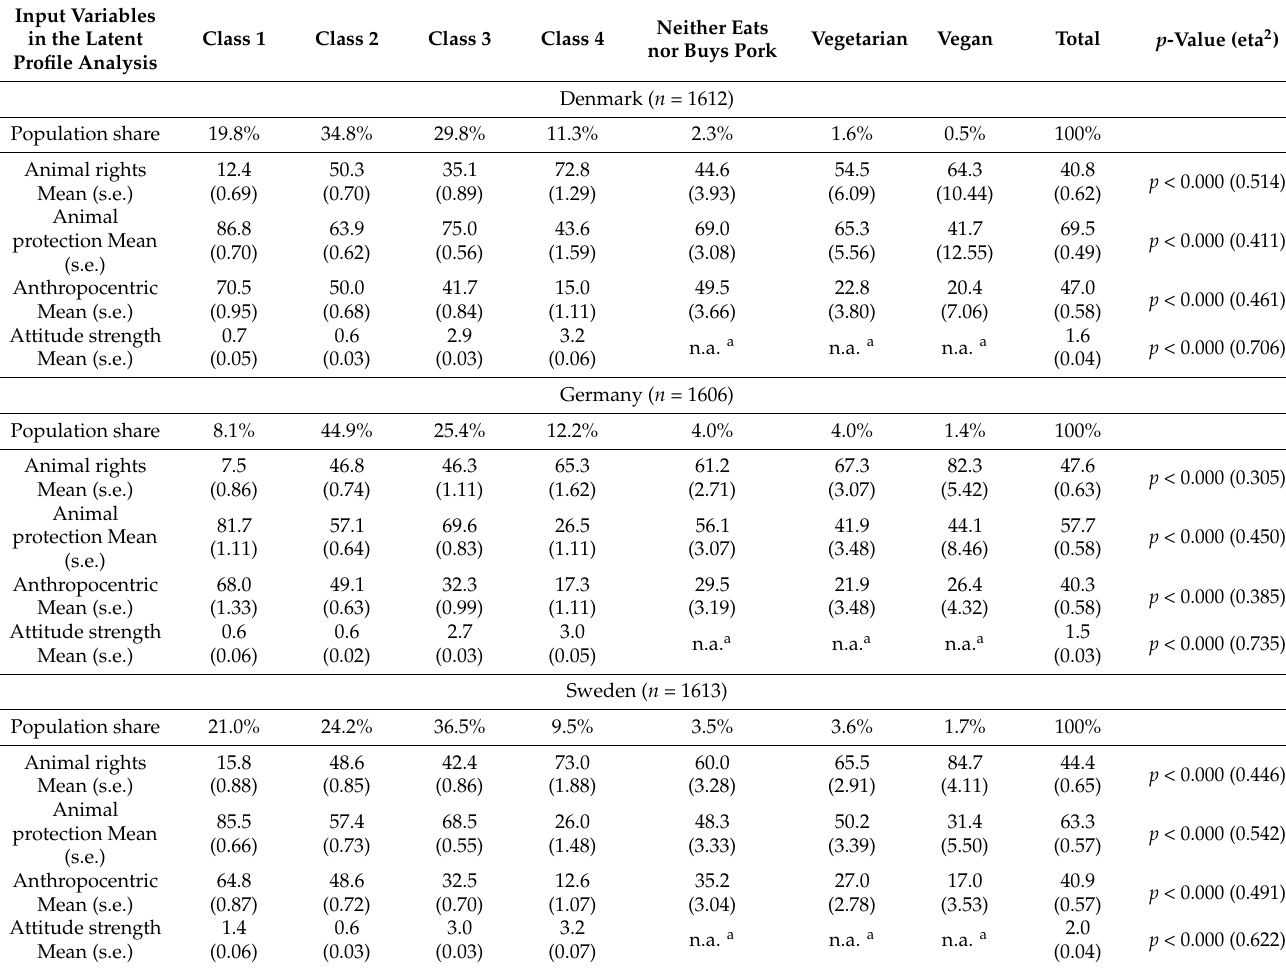
Table 4. Overview of population segments in Denmark, Germany, and Sweden—results of latent profile analysis of pork consumers (class 1 to class 4) and similar overview among non-pork